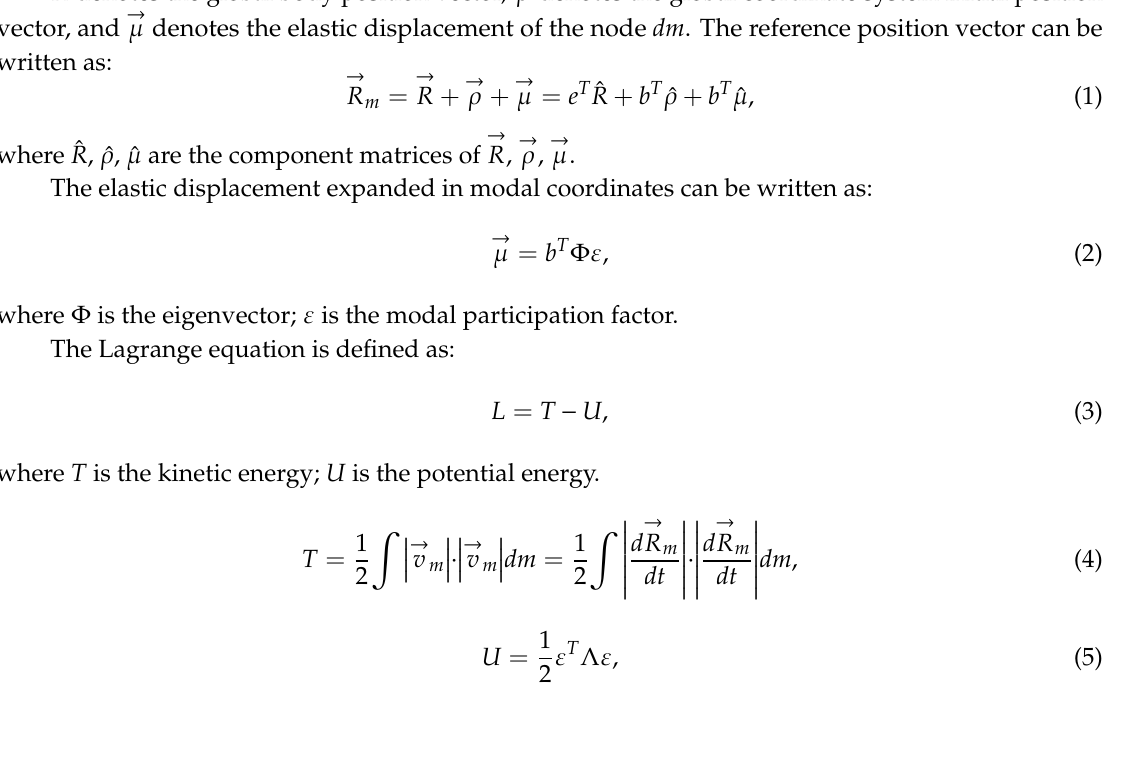
Figure 2. Schematic representation of the floating frame of reference (FFoR) approach.